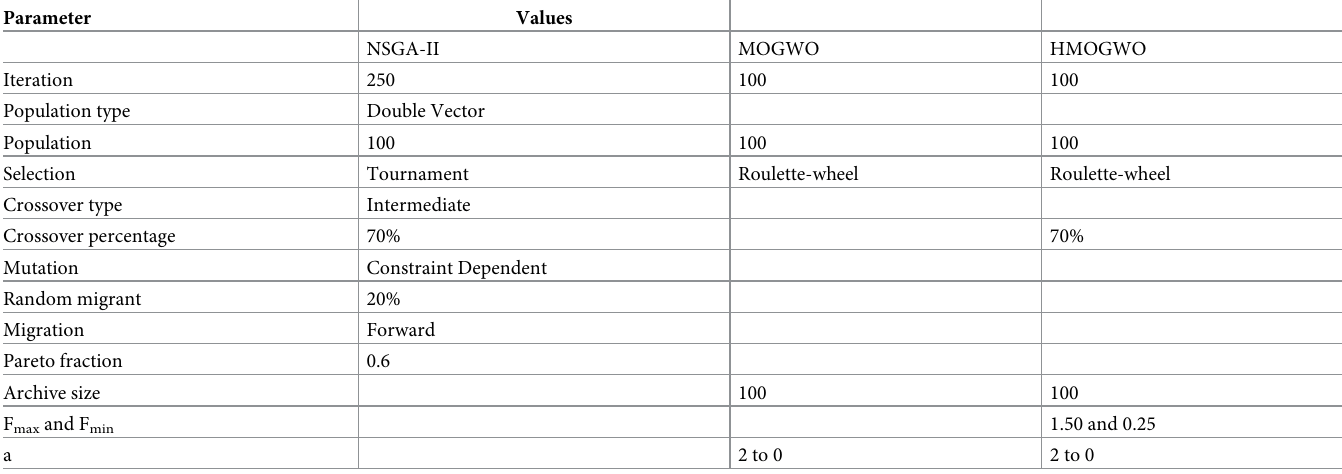
Table 9. Parameter settings of the NSGA-II, MOGWO, and